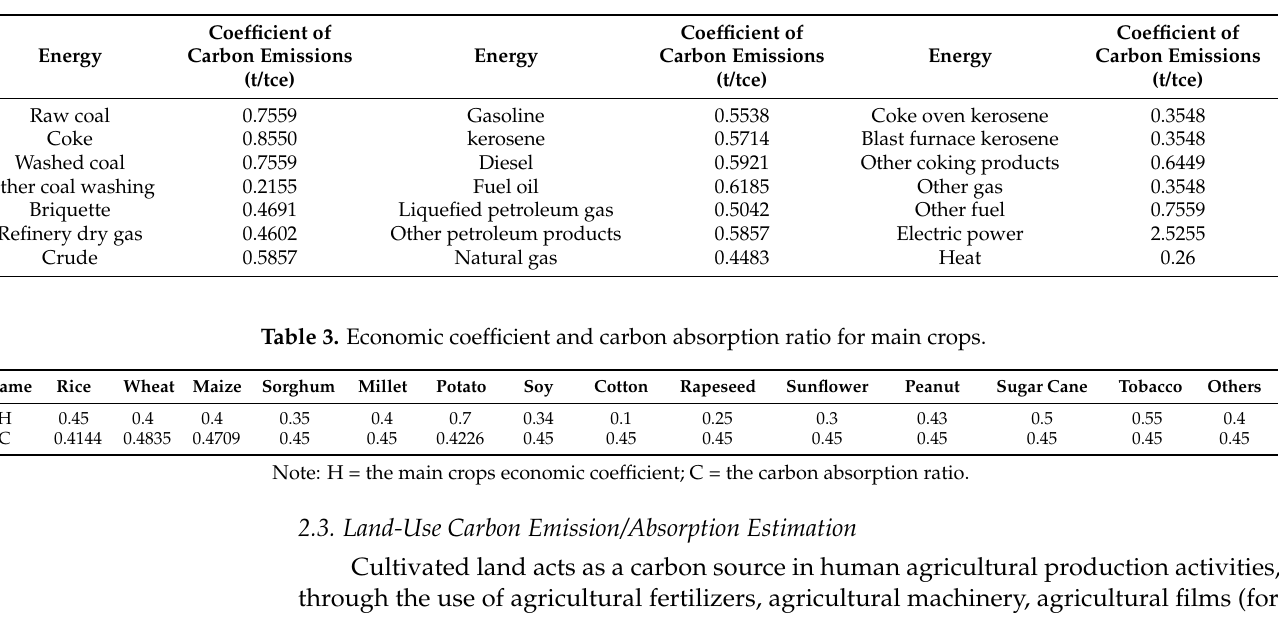
Figure 2. Land use map of PRD in 2015. Table 2. Coefficient of carbon emissions for different energy sources.